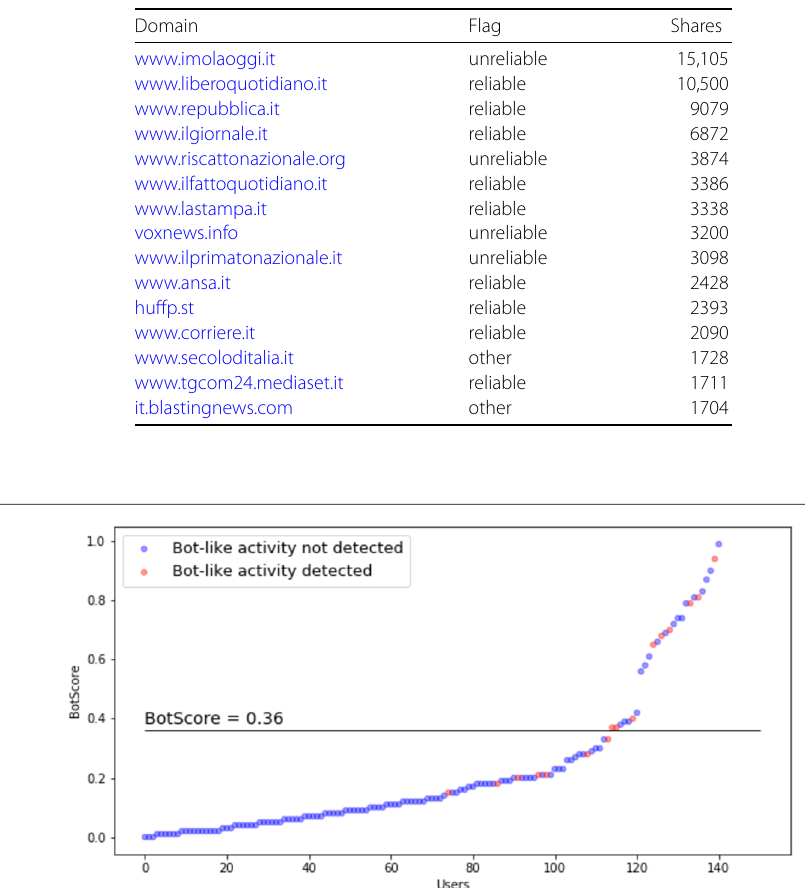
Table 5 List of the top 15 domains by shares